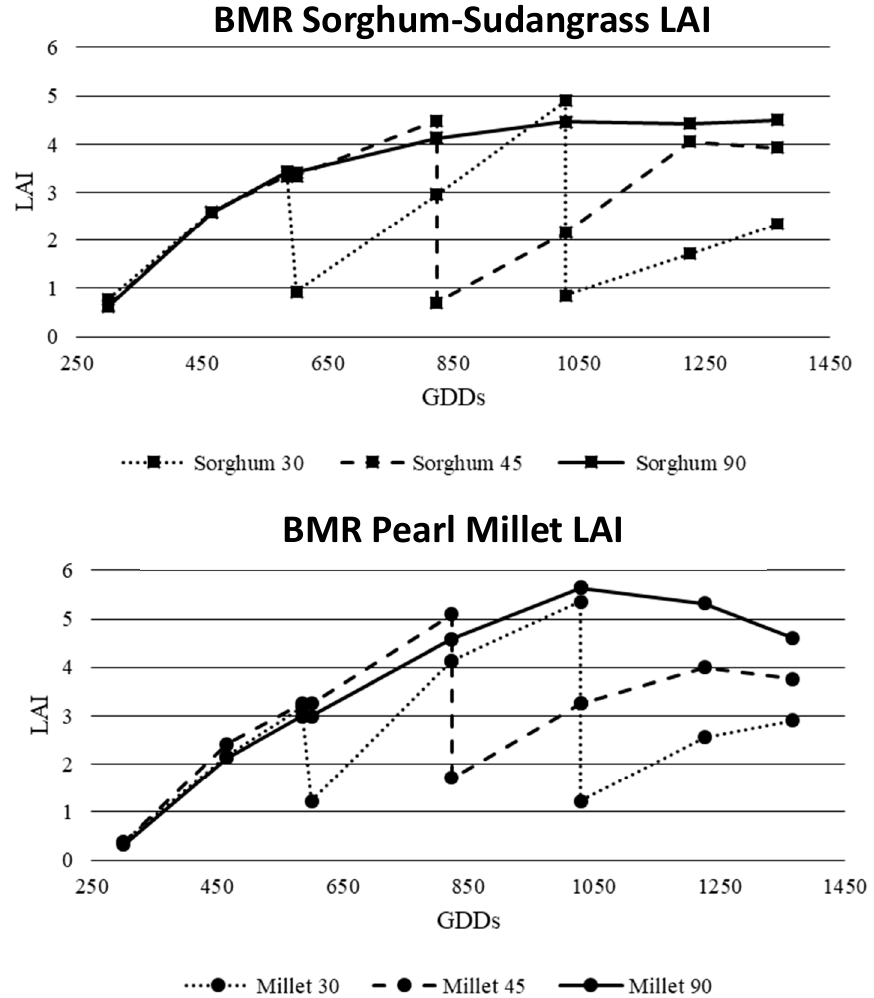
Figure 3. Brown midrib (BMR) sorghum-sudangrass and BMR pearl millet leaf area index (LAI) for three different harvest intervals (three 30-d, two 45-d, and one 90-d) in 2017 at Canyon, TX, USA.